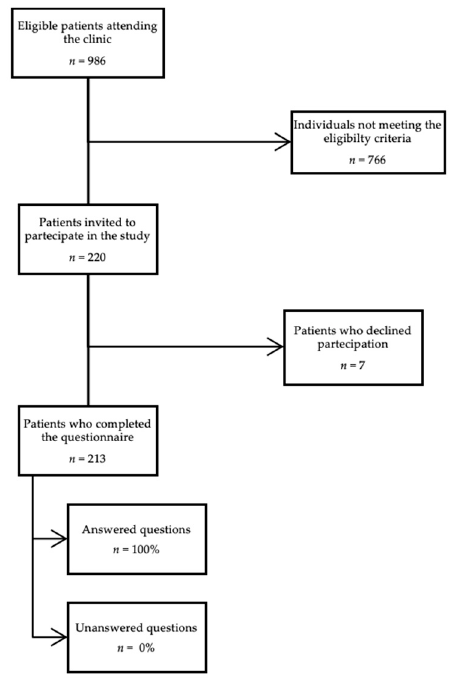
Figure 1. Flowchart of the study.